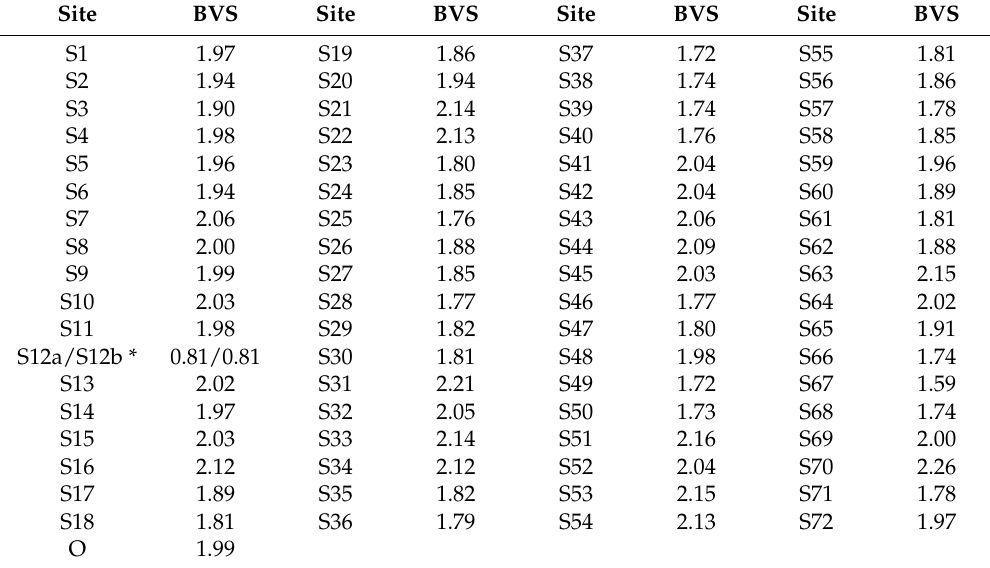
Table 3. Bond-valence sums (BVS) in valence units (v.u.) for anion